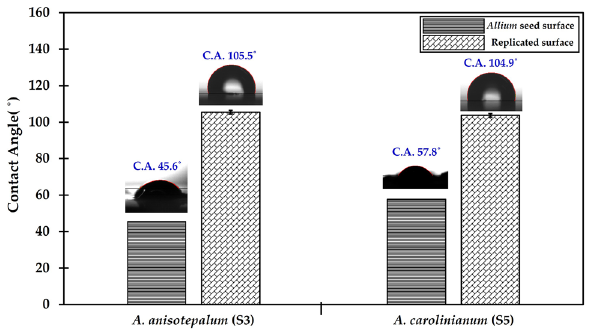
Figure 2. The measured contact angle on original and synthetic surfaces of Allium